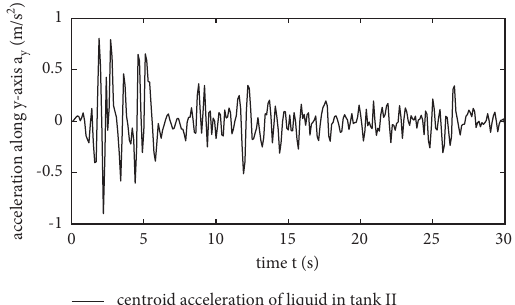
Figure 13: Acceleration curve of mass center of the liquid in tank